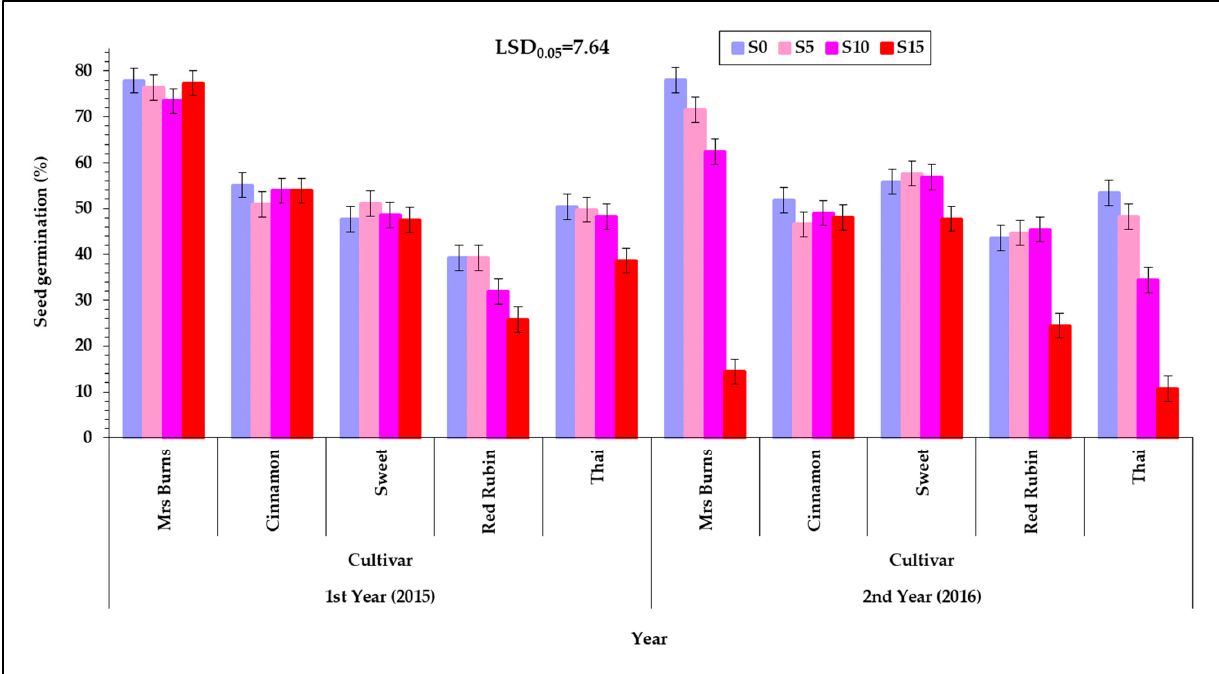
Figure 4. Seed germination of the five basil cultivars (“Mrs Burns”, “Cinnamon”, “Sweet”, “Red Rubin” and “Thai”), at the four PEG concentrations, S 0 for 0% PEG, S 5 for 5% PEG, S 10 for 10% PEG and S 15 for 15% PEG, at the two years of experimentation. Data presented are estimated mean values averaged over all the three irrigation levels. LSD is the least significant difference at the 0.05 significance level. Error bars correspond to the estimated common standard error of the mean values. Each mean value has been estimated utilizing n = 12 measurements. Figure S4 (see Supplementary Material) presents the observed mean values and the corresponding individual standard errors.